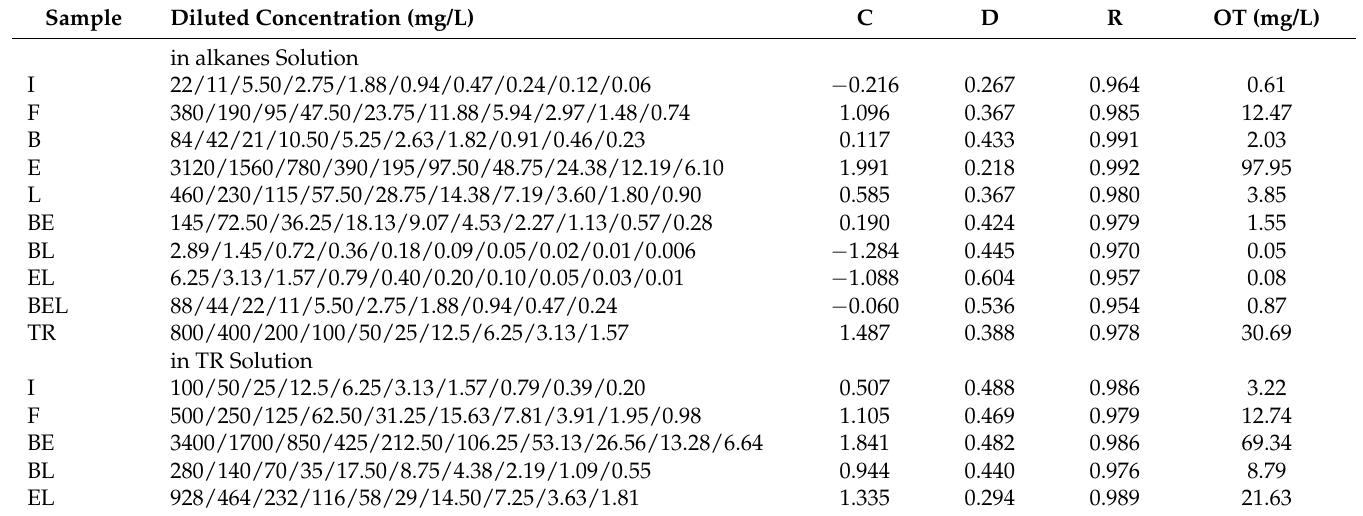
Table 5. Olfactory Threshold of aroma compounds in alkane Solution and TR